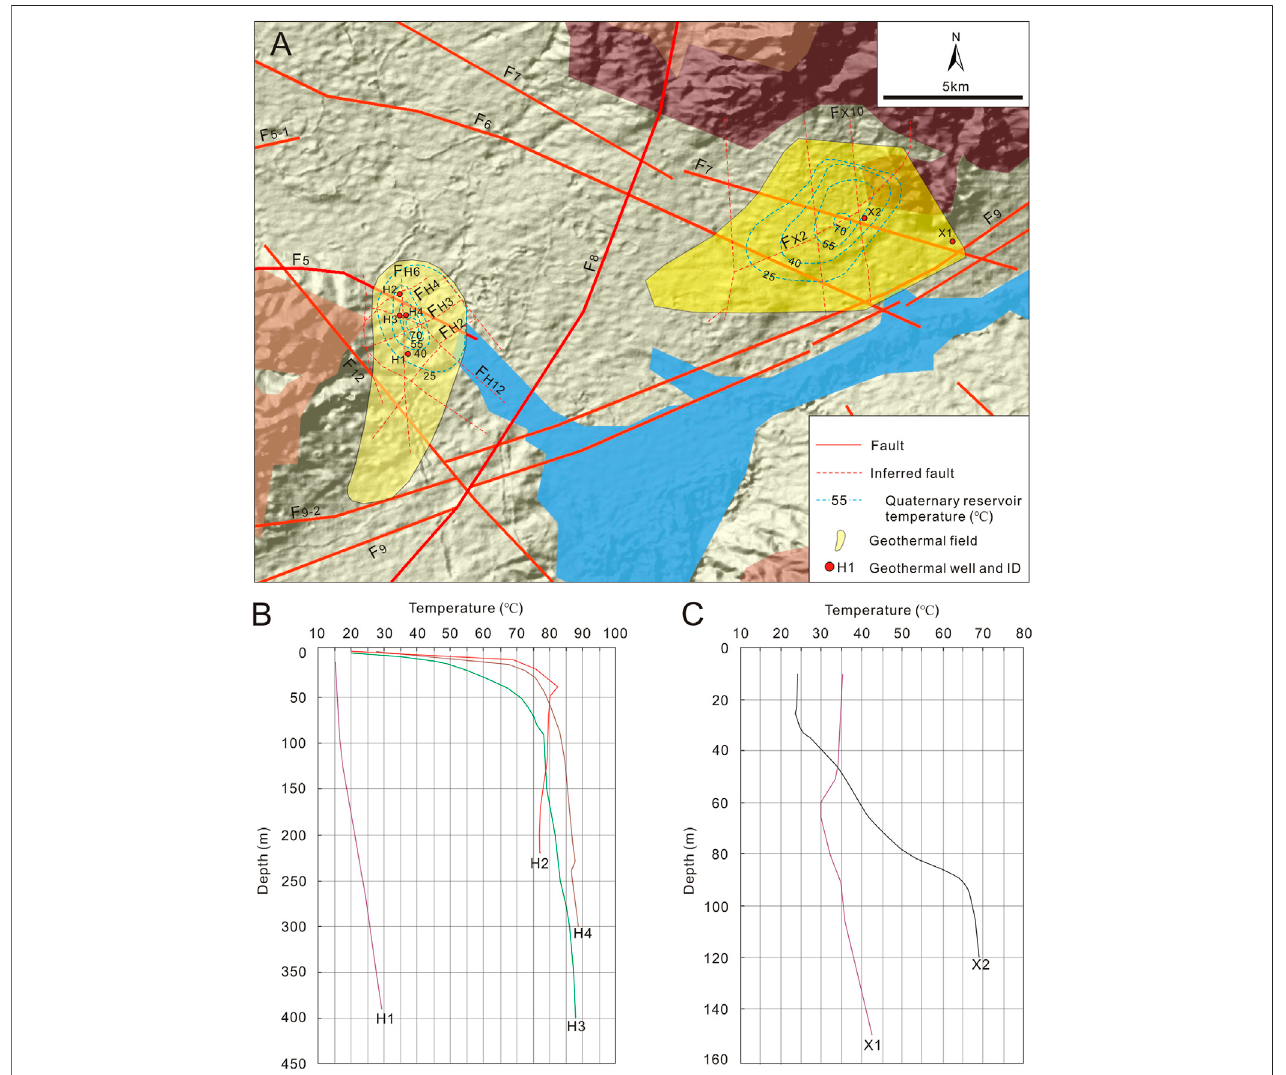
FIGURE8|(A) LocationofHouhaoyaoandXijiabaogeothermal fi elds. (B,C) Temperature – depthcurveofgeothermalwellsinHouhaoyaoandXijiabaogeothermal fi elds, respectively.